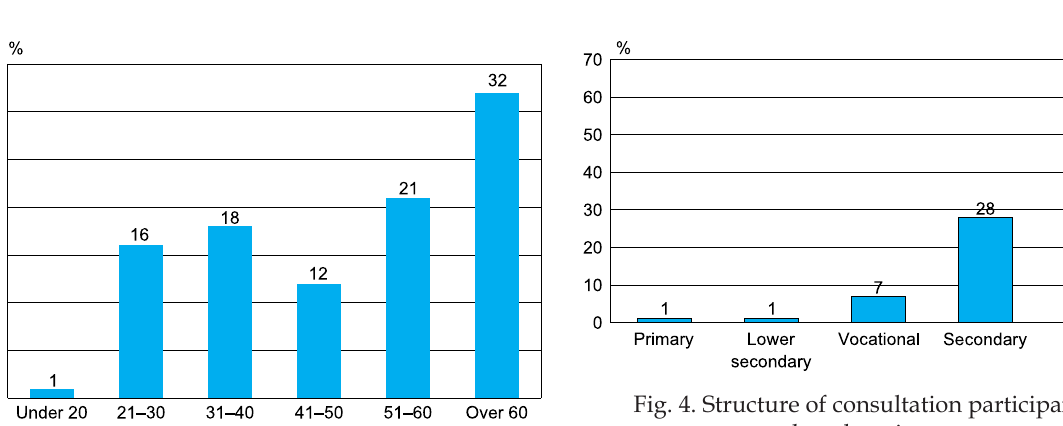
Fig. 4. Structure of consultation participants by education. Source: own compilation.